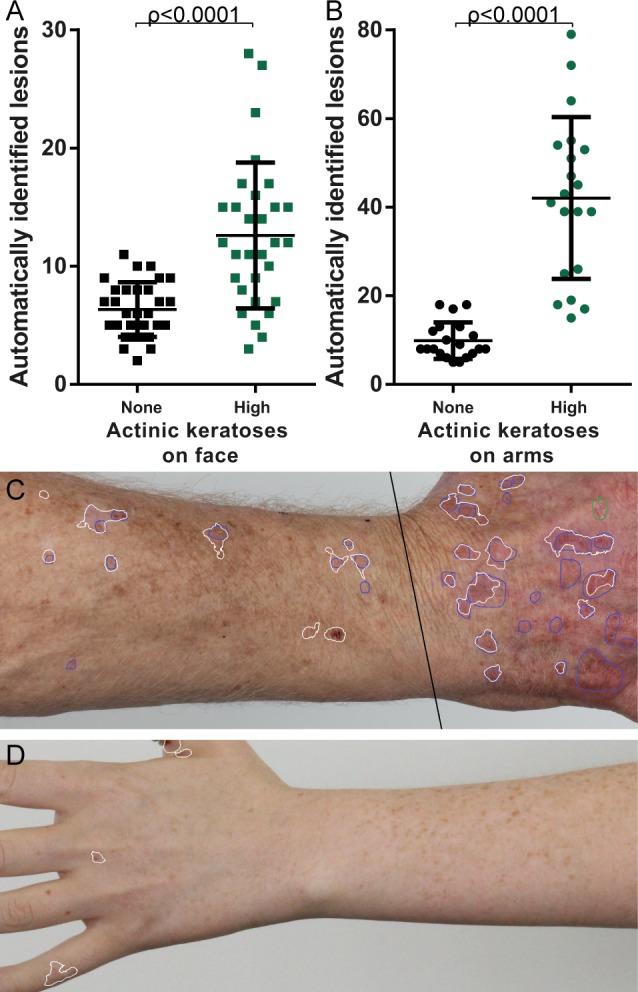
Comparison of automated detection output on low and severe photodamage groups, for all images.A) Lesions counted in each photograph of the face for both low and severe photodamage groups. B) Lesions counted in each photograph of the arm for both low and severe photodamage groups. C) Example output on hand and forearm from severe photodamage group. D) Example output on hand and forearm from low photodamage group.